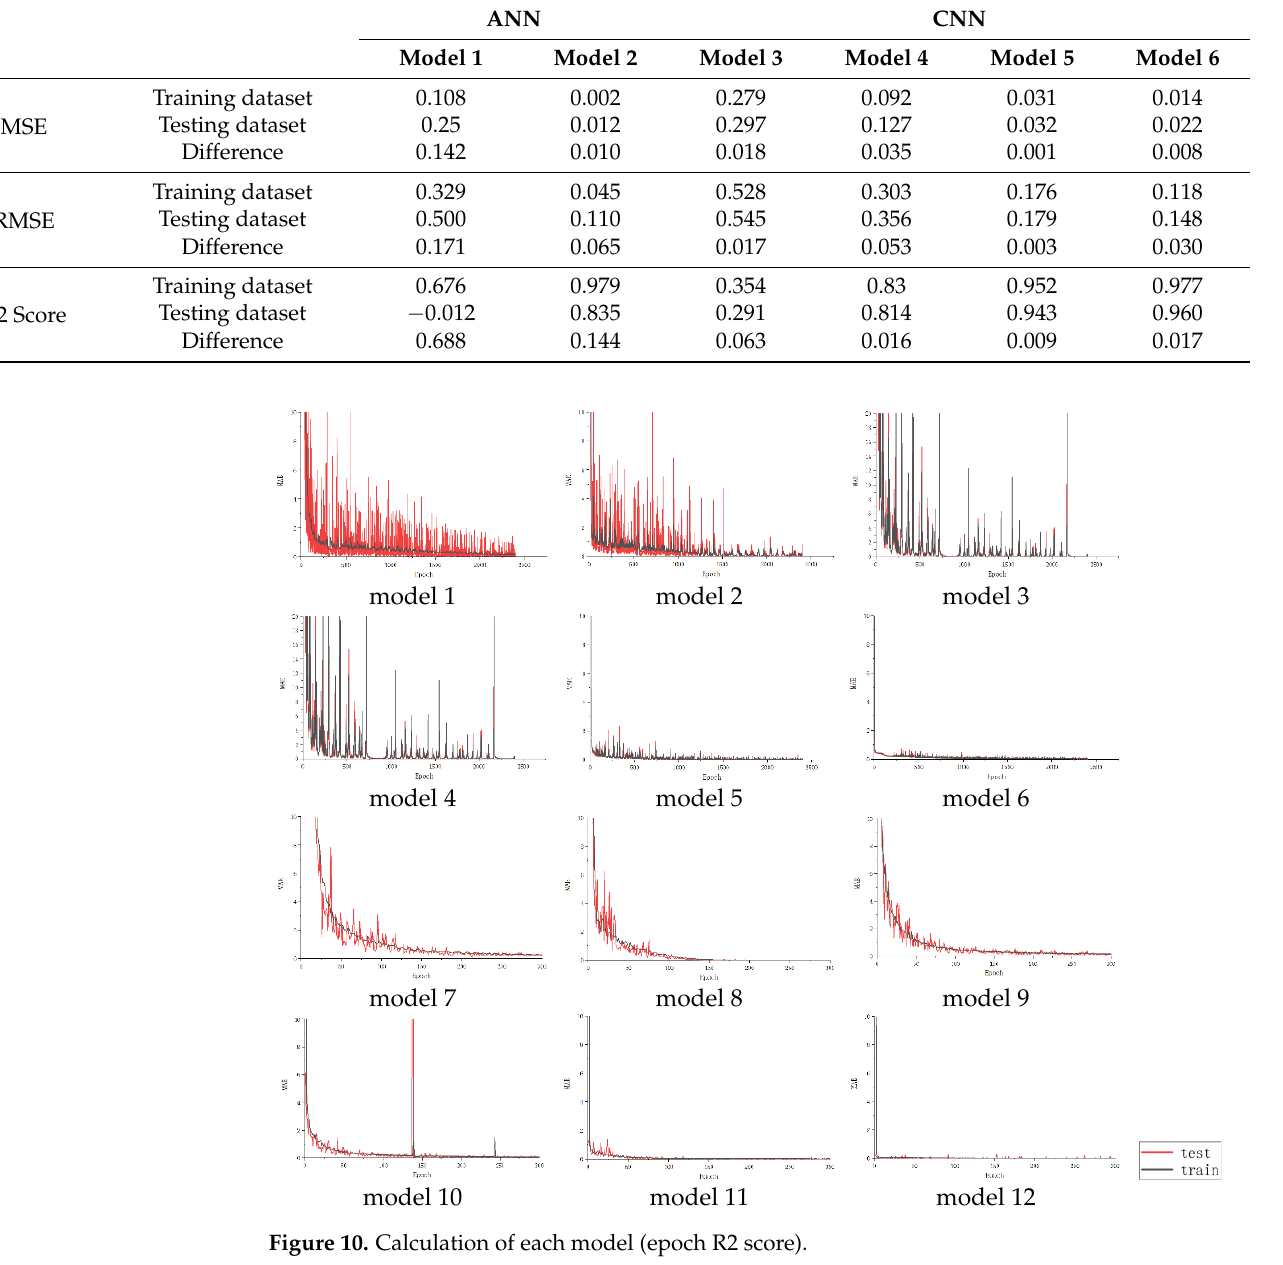
Table 9. Performance of Group B models at 300 epochs.